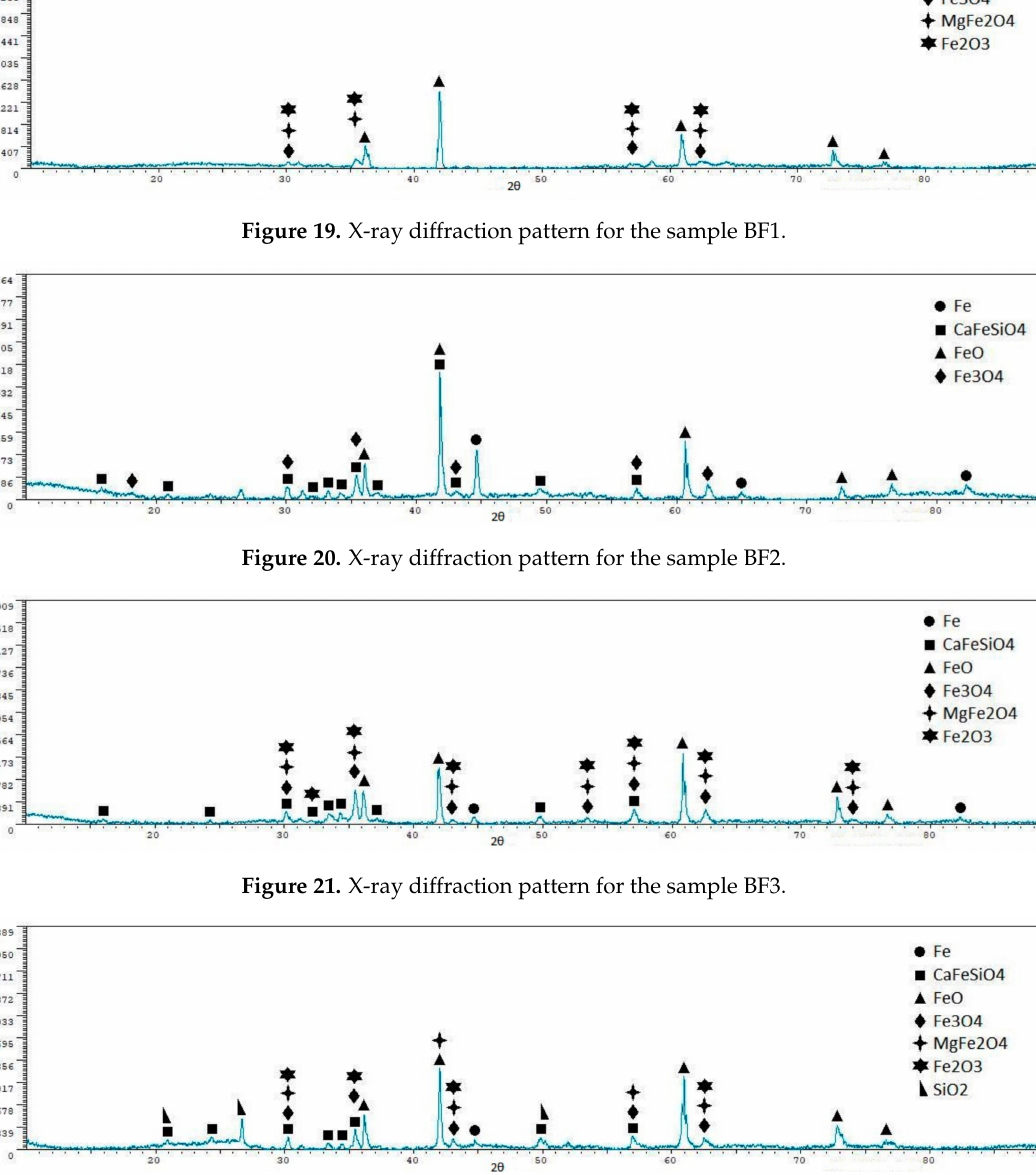
Figure 22. X-ray diffraction pattern for the sample BF5. Table 14. Chemical analysis of the samples discounting the presence of amorphous phases.